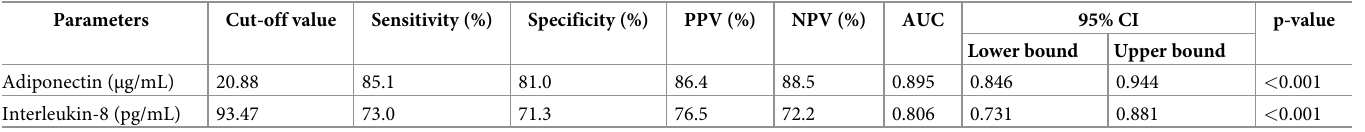
Table 3. Receiver operating characteristic curve analysis of serum adiponectin and interleukin-8.